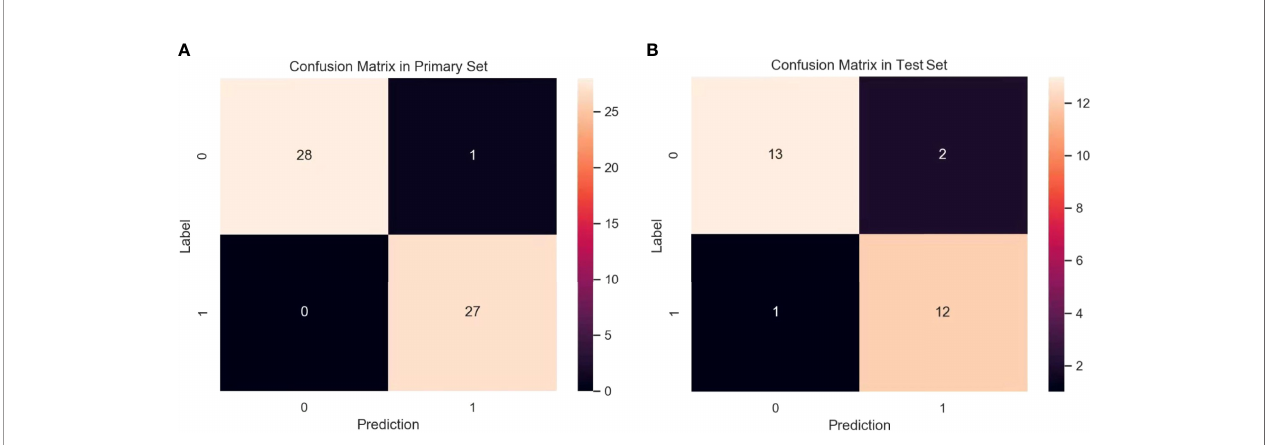
FIGURE 4 | Confusion matrix for the model in primary set (A) and test set (B) . A confusion matrix was used to examine whether or not there was consistency between the stage III type 2 DN and normal subjects. Different colors represent different cases. The color becomes lighter as the number increases. (Note: Numbers 0 and 1 represent normal patient and DN,